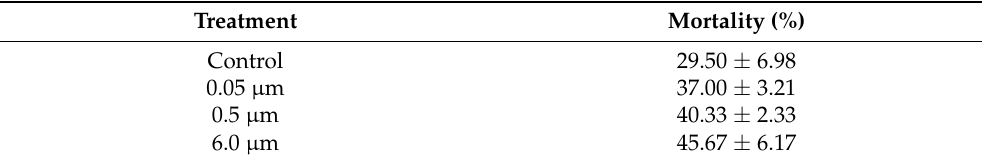
Table 2. Effects of PS-MPs of different sizes on embryo mortality (n = 100). Data are expressed as mean ±